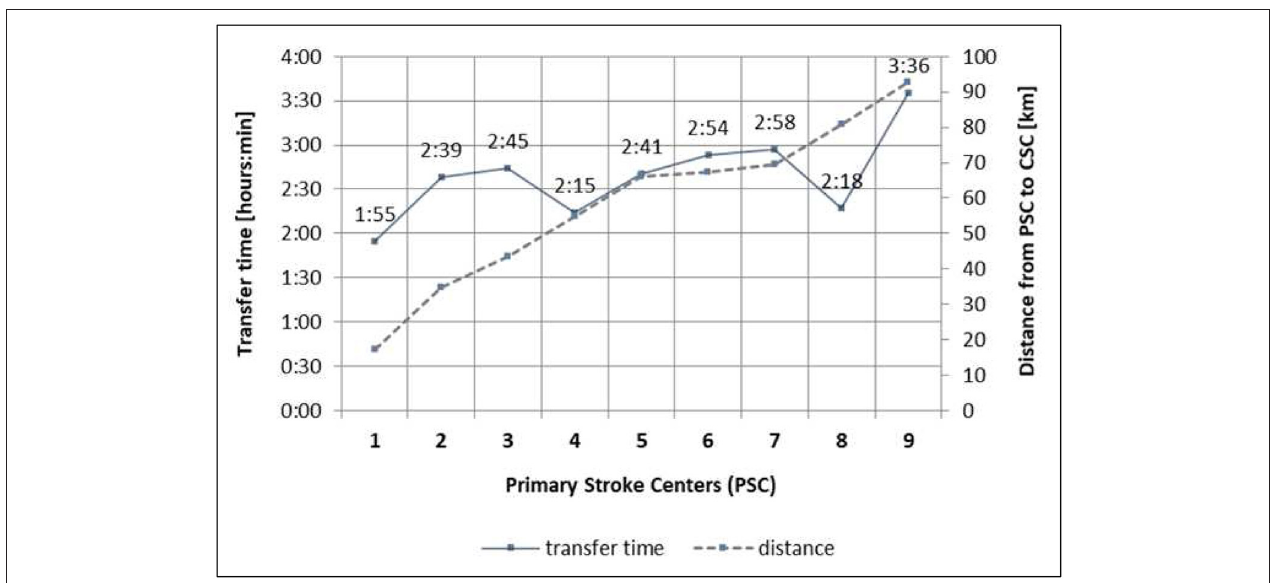
FIGURE 1 | Neurovascular network with distances and transfer times from PSC to CSC. PSC, primary stroke centers; CSC, comprehensive stroke center (Freiburg); 1. PSC 1 with local stroke care, 2. PSC 2 with local stroke care, 3. PSC 3 with local stroke care, 4. PSC 4 with regional stroke care, 5. PSC 5 with regional stroke care, 6. PSC 6 with regional stroke care, 7. PSC 7 with regional stroke care, 8. PSC 8 with local stroke care, 9. PSC 9 with local stroke